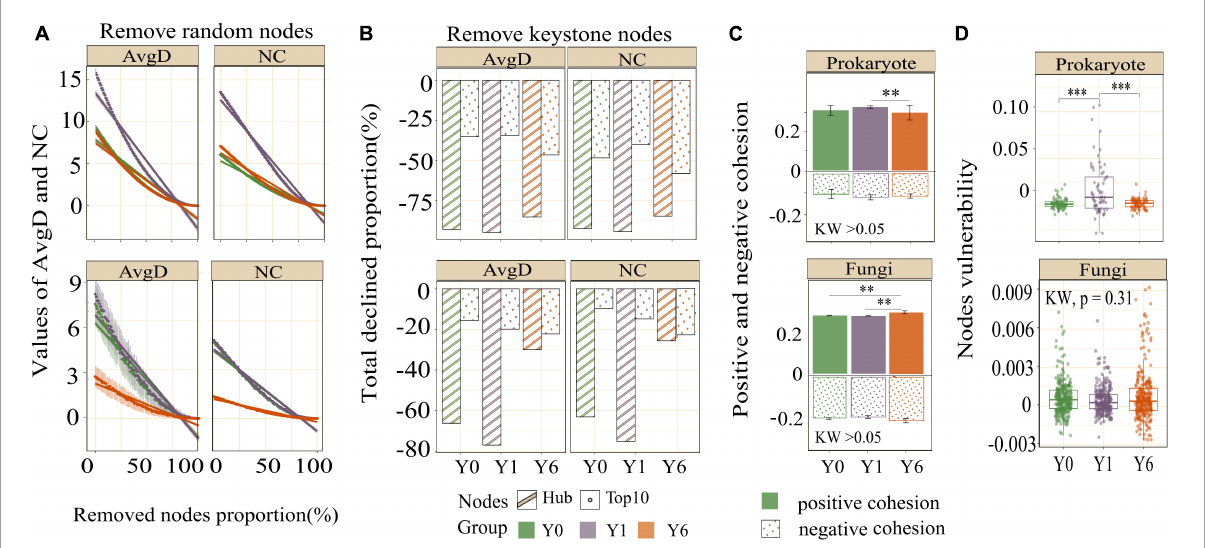
FIGURE4 The network stability of three networks. Figures in the first row are the results of prokaryotes and figures in the second row are the results of fungi. Images in panel (A) are the AvgD and NC with the removal of random nodes, images in panel (B) are the total declined proportions of AvgD and NC since removing all keystone nodes, images in panel (C) are the negative and positive cohesion, and images in panel (D) are the node vulnerability. *, **, and *** indicate significant differences at 0.05, 0.01, and 0.001 level, respectively.